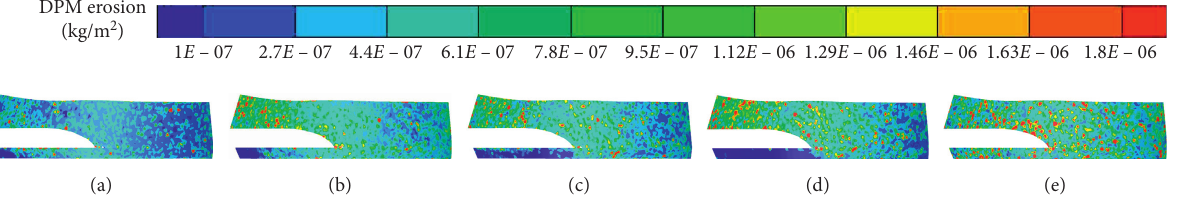
Figure 14: Pressure surface wear clouds at different particle volume concentrations. (a) C � 10%, (b) C � 15%, (c) C � 20%, (d) C � 25%, and (e) C � 30%.